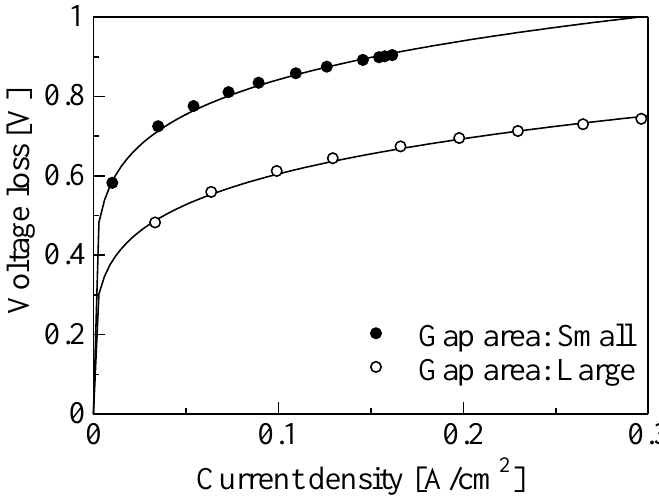
Figure 11. Activated polarization for different gap areas.